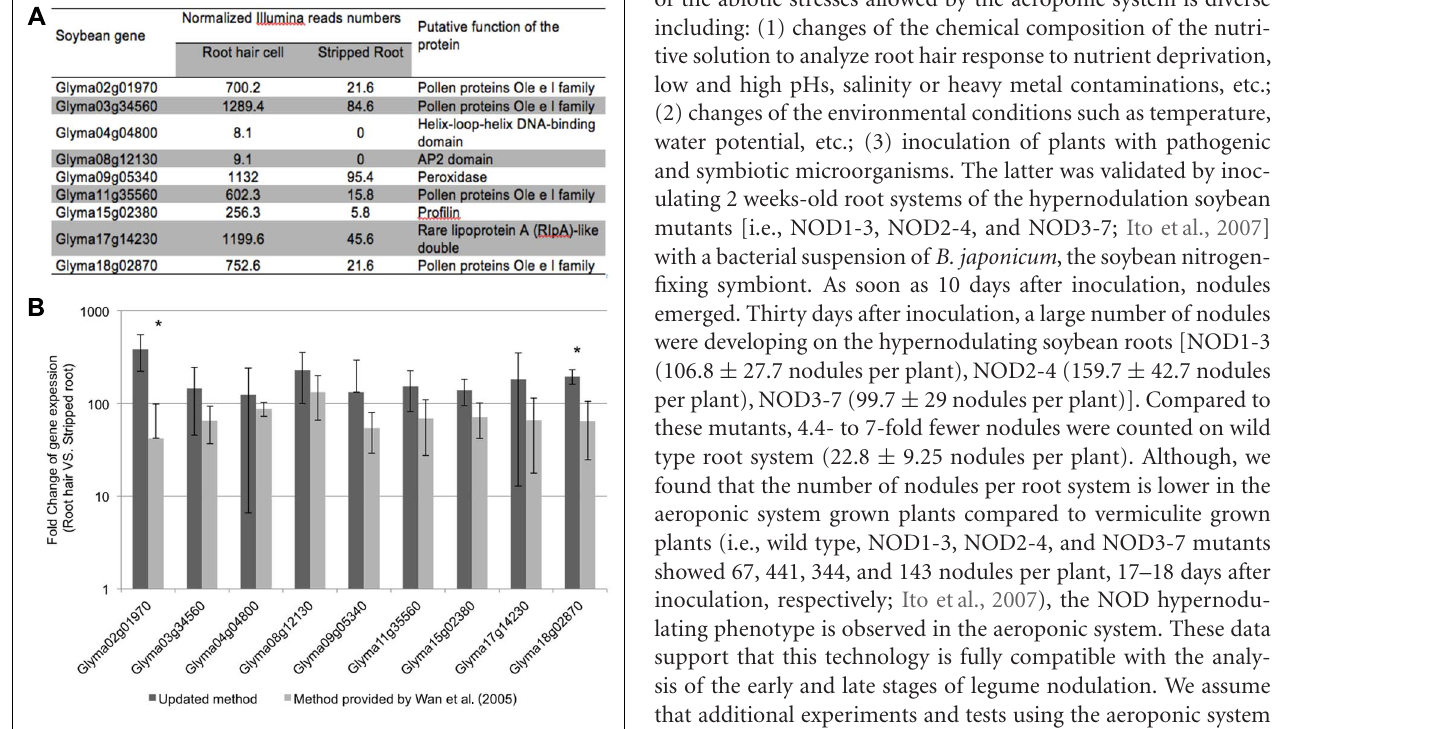
FIGURE 4 | Expression analyses of soybean root hair specific genes. ( A ) Relative expression levels of nine soybean genes in root hair cells and stripped roots from the Illumina read data (Libault etal., 2010c); ( B )The fold-change of the expression of nine root hair specific genes was quantified between isolated root hairs and stripped roots.The plant material was generated using our optimized protocol (dark bars) and the method provided byWan etal. (2005) (light gray bars). For each experiment, a minimum of three biological replicates were performed and analyzed.The student t -test was applied to highlight significant differences between these two methods.The asterisk indicates significantly difference (* p <